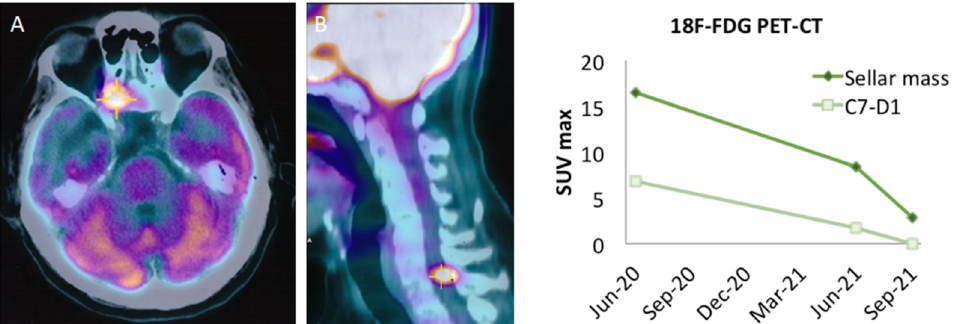
Figure 4. Metabolic response to pembrolizumab : Shown is representative imaging obtained by 18 FDG-PET-CT before treatment (( A ), sellar/parasellar mass; ( B ) main spinal metastasis C7–D1) and the metabolic response, illustrated by the evolution of SUV max at 18 FDG PET-CT before and after 4 and 8 cycles of treatment.